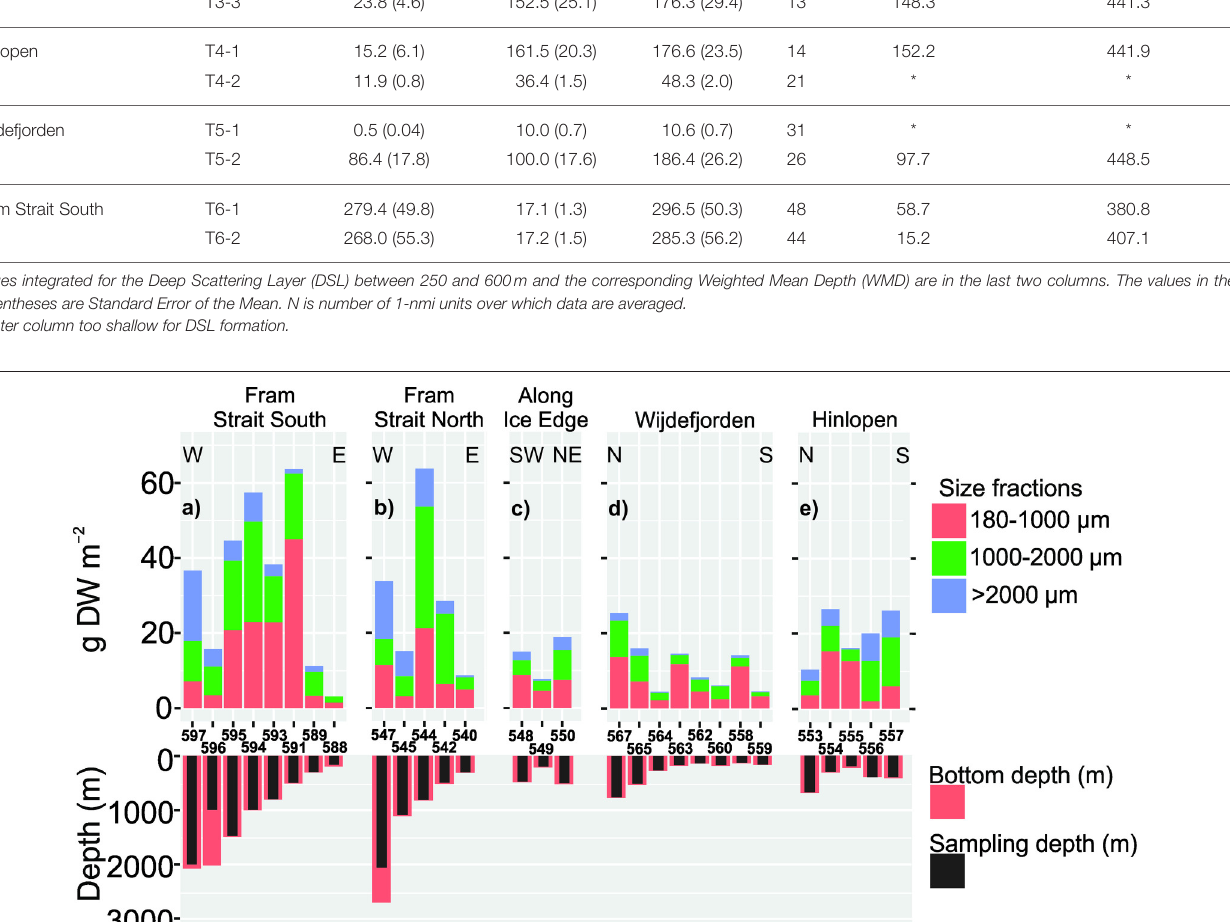
component across the central shelf and the slope region north of